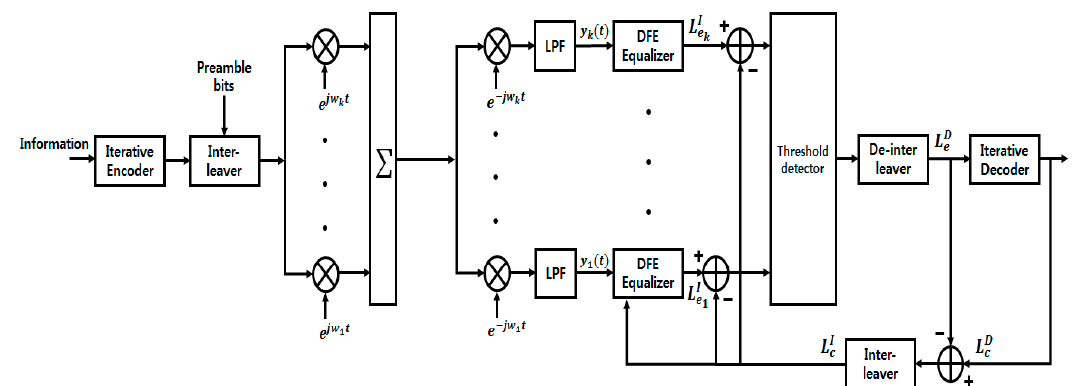
Figure 2. Transceiver structure of multi-band communications.